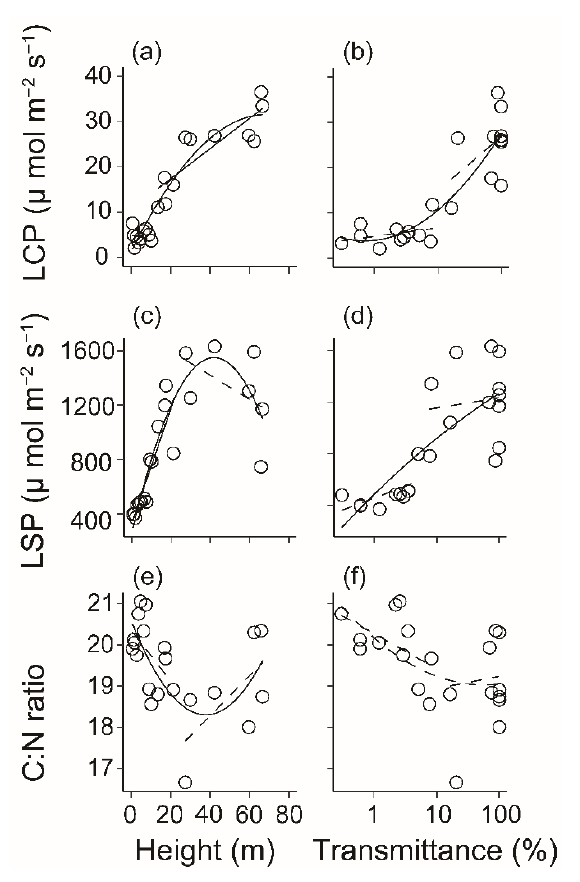
Figure 9. Light compensation point (LCP), light saturation point (LSP), and carbon-nitrogen ratio (C:N ratio) plotted against tree height ( a , c , e ) and light (represented as ln(%TRANS)) ( b , d , f ). Lines indicate the linear piecewise regression results; solid lines denote significant relationships ( P < 0.05), and broken lines denote nonsignificant relationships. The curve indicates the quadratic regression result. Note that a natural log scale is used on the X-axis in panels ( b , d , f ).